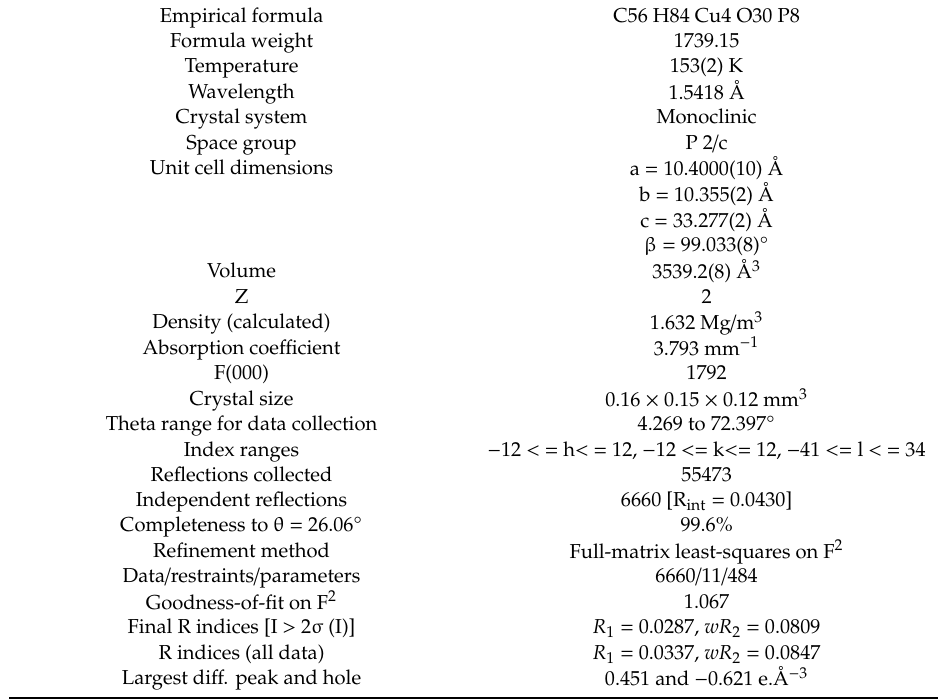
Table 1. Crystal Data and Structure Refinement for 1